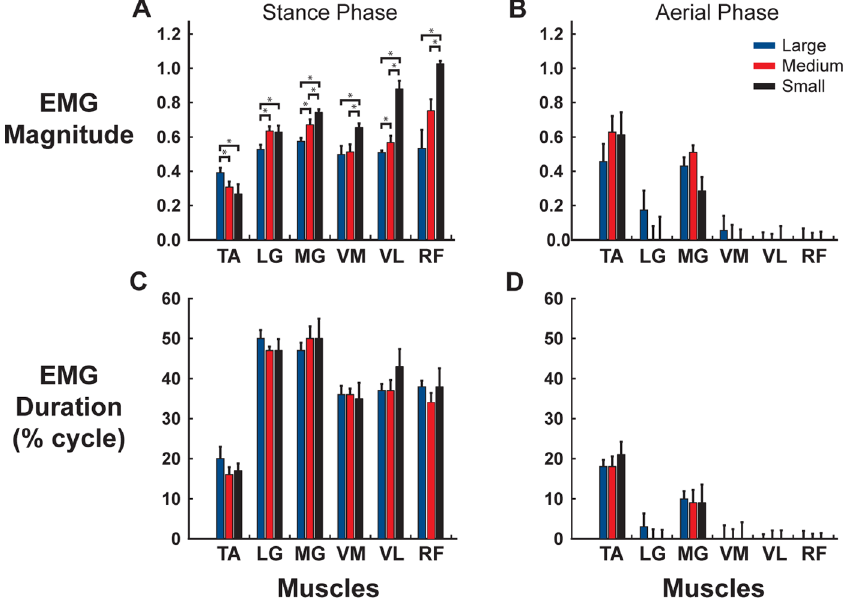
Figure 7. Mean muscle activity as a function of target size. EMG burst activity magnitude (a–b) and EMG burst duration (c–d) during stance and aerial phase for the three targeting conditions (large: blue, left; medium: red, middle; small: black, right). Magnitude of activity increased for all muscles in smaller, more smaller target sizes compared to the large, easier condition except for TA, which showed a significant decrease. No changes were observed for burst duration. *denotes significant difference (p ,